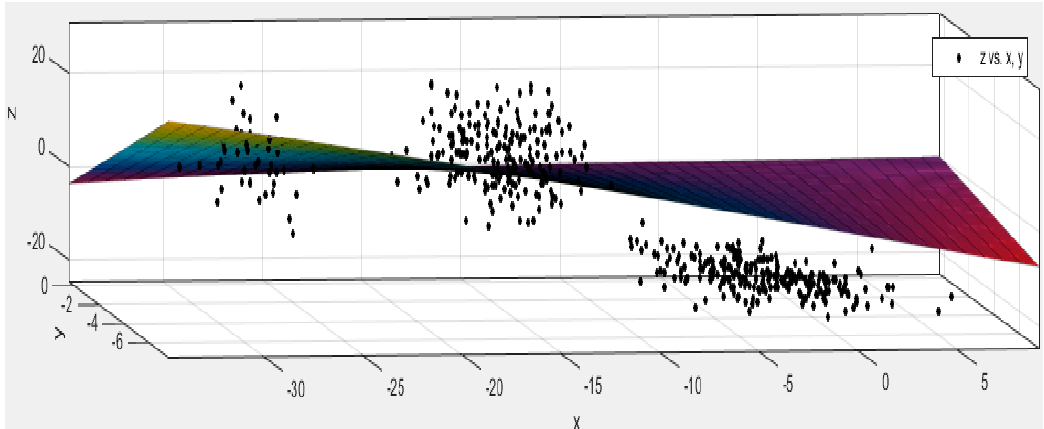
Figure 11. Fitting chart of traffic flow data at 10 s interval.